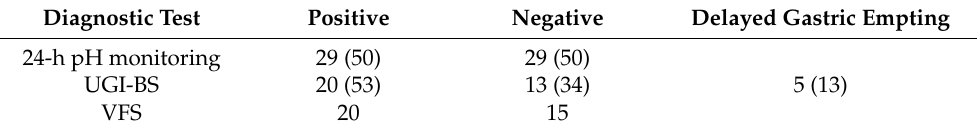
Table 2. Details on pre-operative diagnostic